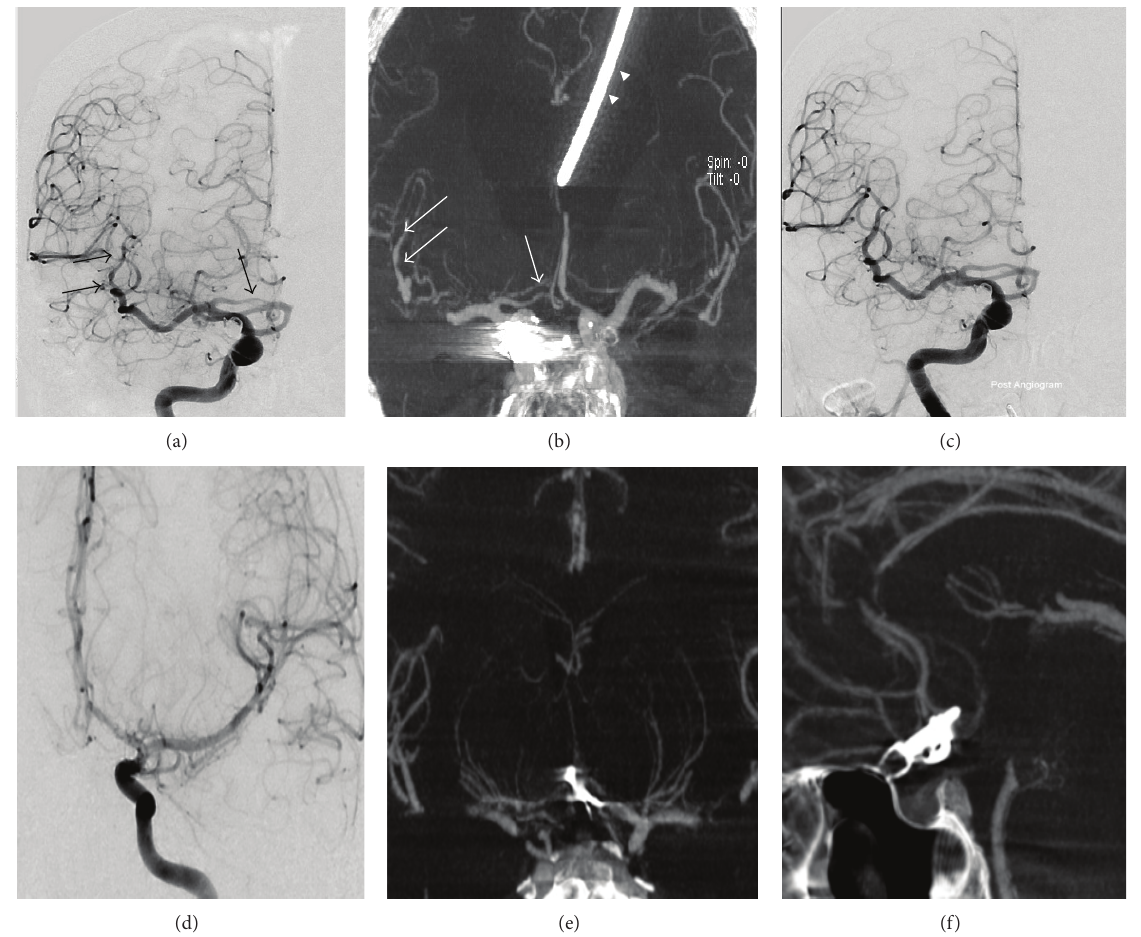
Figure 2: An 81-year-old female was transferred for ruptured aneurysm of the posterior communicating artery. (a and b) Digital subtraction angiography(DSA)andIVFDCTtaken5daysafterthecoilembolizationrevealedmoderatevasospasmoftheM2andA1(arrows)(arrowhead indicates a catheter of the extraventricular drainage). (c) DSA after chemical angioplasty using nimodipine shows the improvement of blood flow. A 22-year-old male was transferred for ruptured aneurysm of the anterior communicating artery. (d, e, and f) DSA and selective coronal and axial maximal intensity projection image of IV FDCT show no evidence of